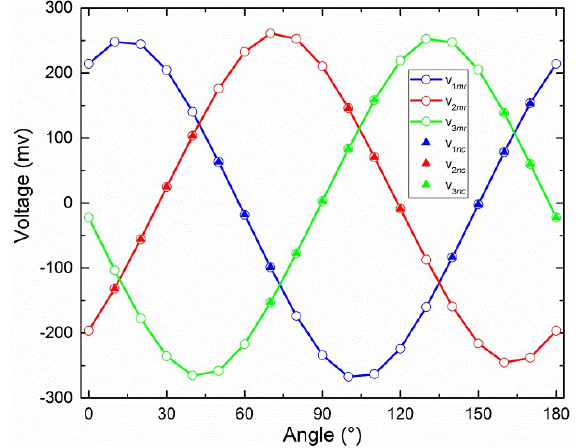
Figure 17. Estimated voltage curves for Section 4.3 and noncontinuous points for Section 4.4.